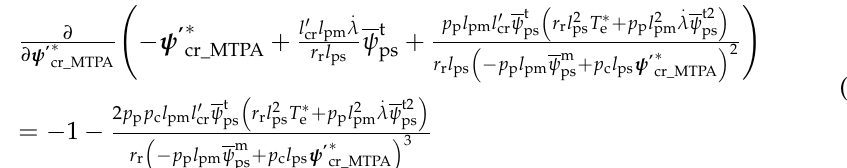
C on t r o l O b j ec t Figure 3. MTPA-(SFV-FLC) optimized control block diagram. In order to show the rule that the MTPA control changes with speed and torque, the CM rotor flux is solved offline by combining (8)–(10) and the MTPA Equation (21). Based on Table 1,